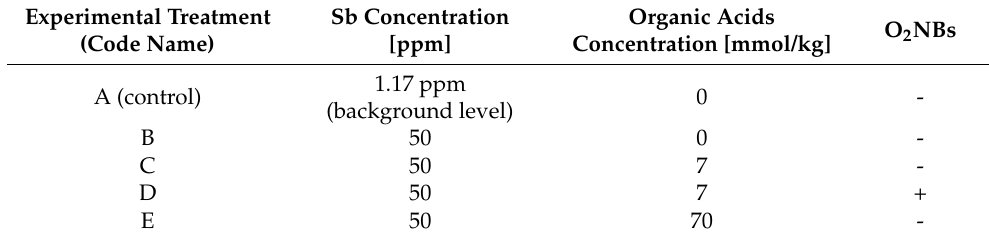
Table 4. Experimental